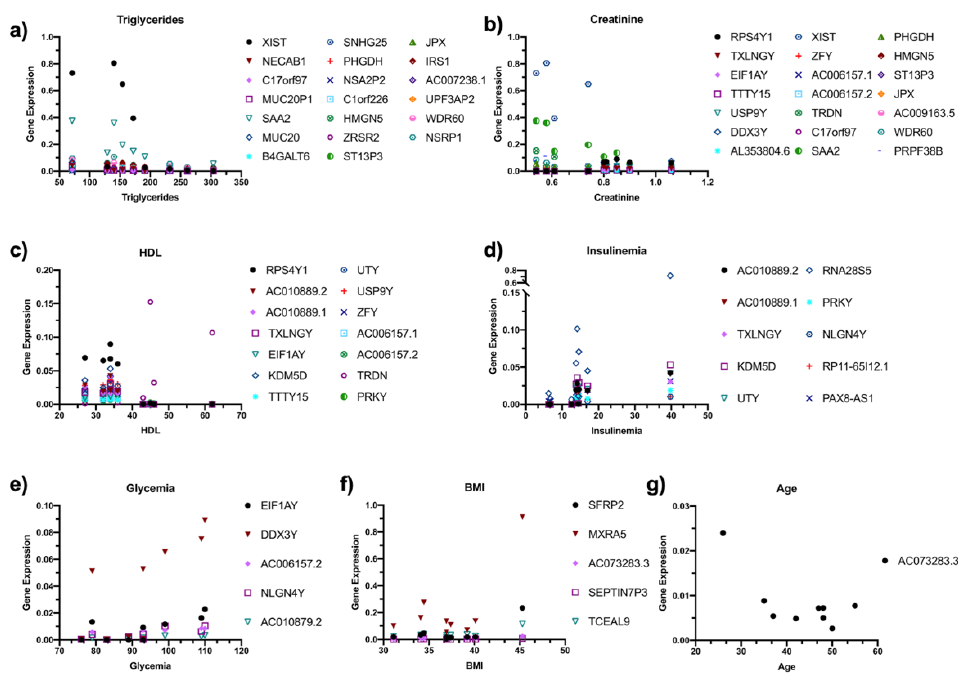
Figure 8. Correlation analysis of anthropometrical parameters with DE RNAs. The correlation between the expression of DE RNAs and the subject’s anthropometrical parameters was investigated, and the significantly correlated DE RNAs are displayed as correlation plots. The gene expression was correlated with ( a ) Triglycerides, ( b ) Creatinine, ( c ) HDL, ( d ) Insulinemia, ( e ) Glycemia, ( f ) BMI, and ( g ) Age.